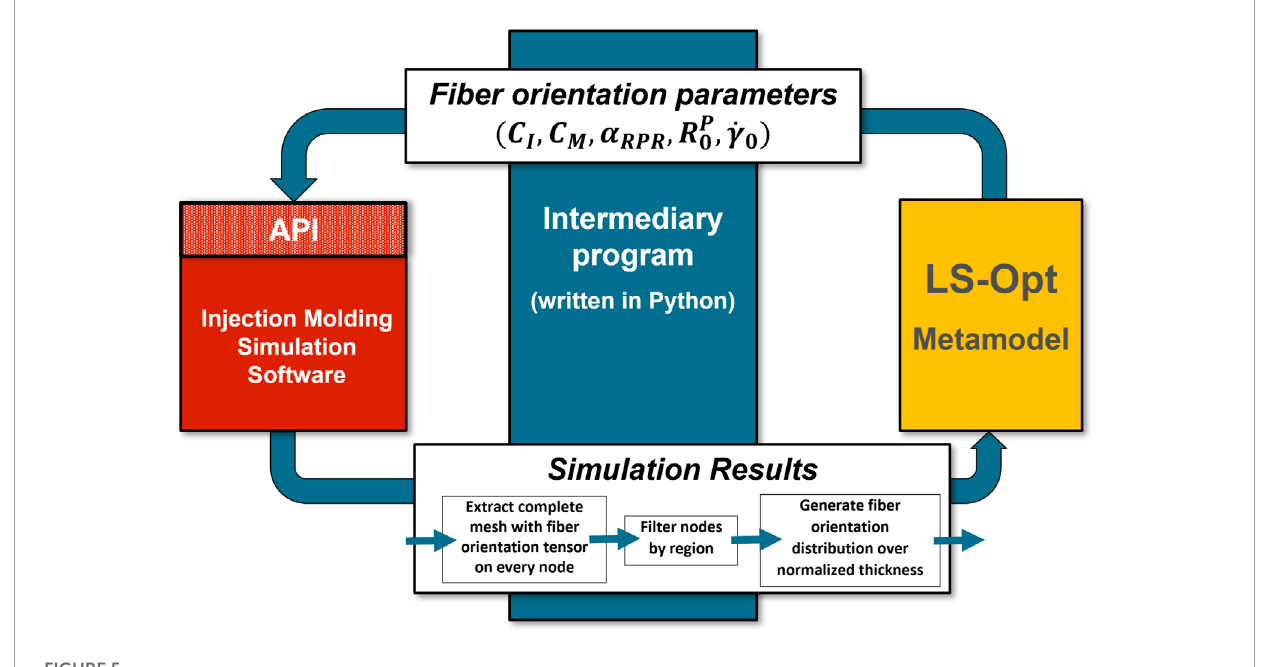
FIGURE 5 Tasks of the intermediate Python program.